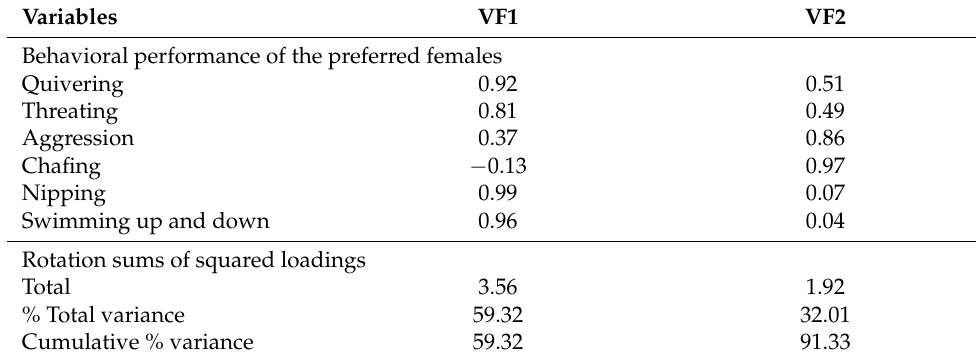
Table 2. PCA outcomes of preferred females in experiment 1.